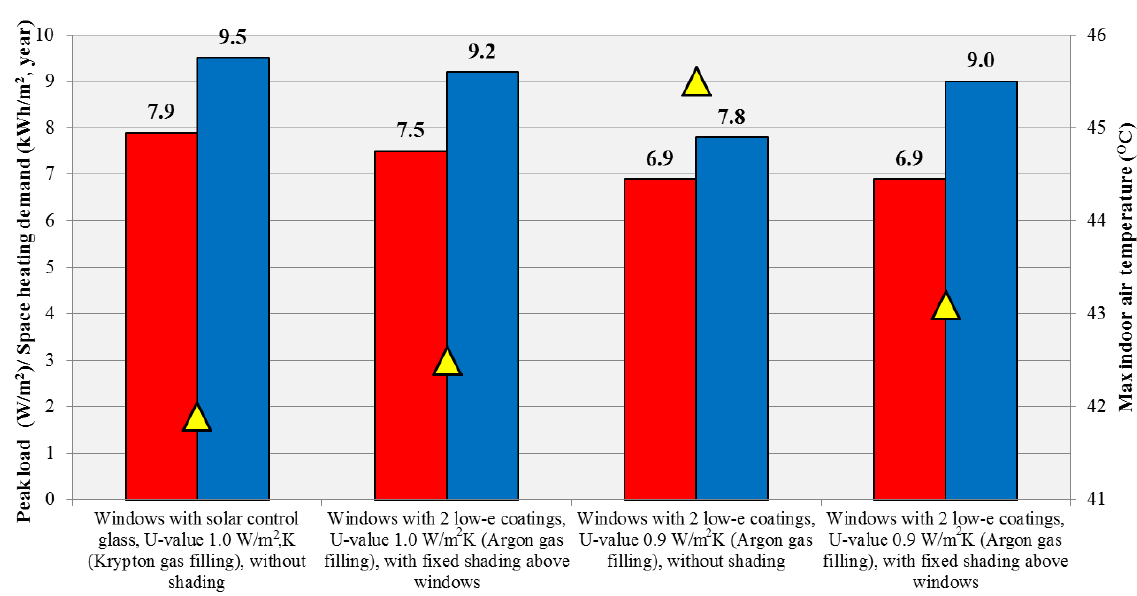
Figure 2. Annual peak load, space heating demand and maximum summer indoor temperatures with different window and shading options. No manual airing of the apartments was included in the simulations. By-pass of the heat exchanger was used in the